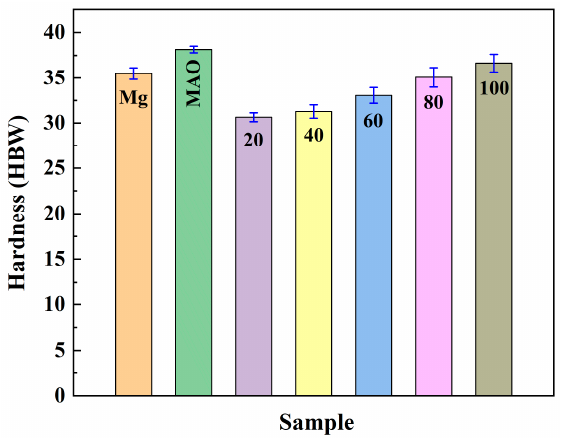
Figure 4. The hardness variation of samples with different surface states.